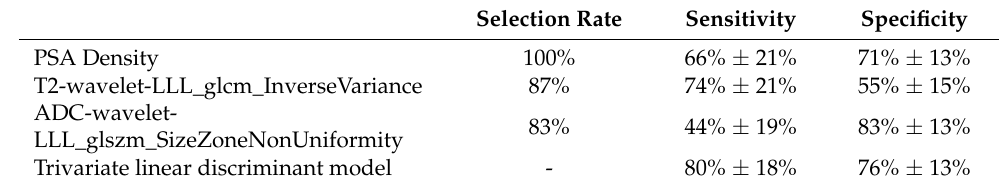
Table 5. Selected features and performance of univariate and best multivariate models. Selection Rate